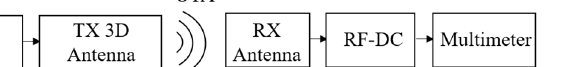
Figure 14. Block diagram of the measurement setup to characterize the WPT system.